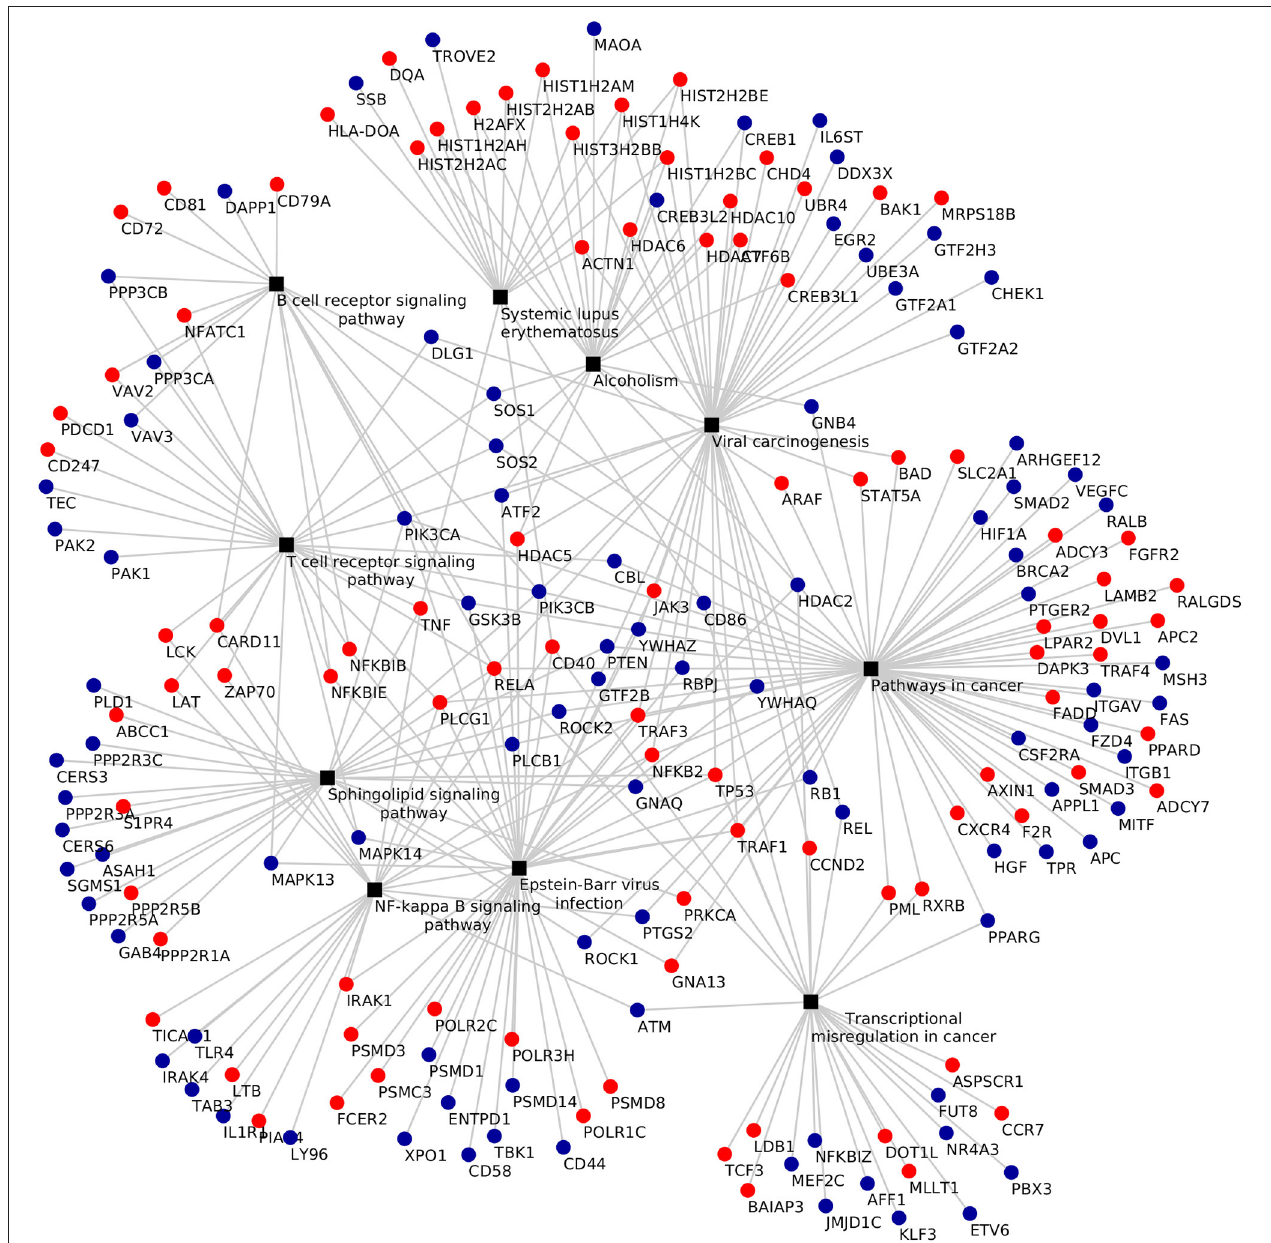
FIGURE 6 | Enriched KEGG pathways in the Adj Tf vs. Adj T0 comparison in DAVID with EASE Score (a modified Fisher’s exact test) and Benjamini-Hochberg False Discovery Rate correction. Black boxes represent different pathways and the points the differentially expressed genes in each pathway, up-regulated ones in red and down-regulated ones in